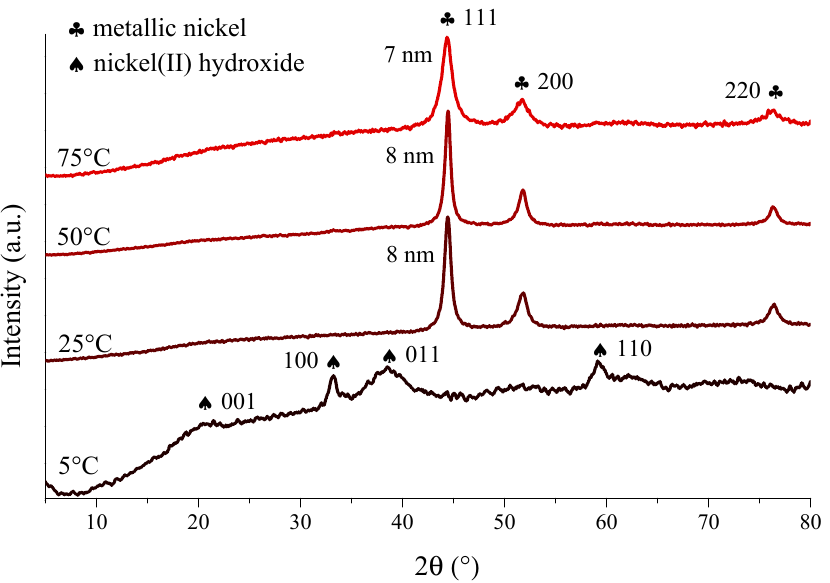
Figure 1. XRD patterns of the nickel nanoparticles prepared by 4 h continuous ultrasound treatment at 30 W output power and varied reaction temperatures.